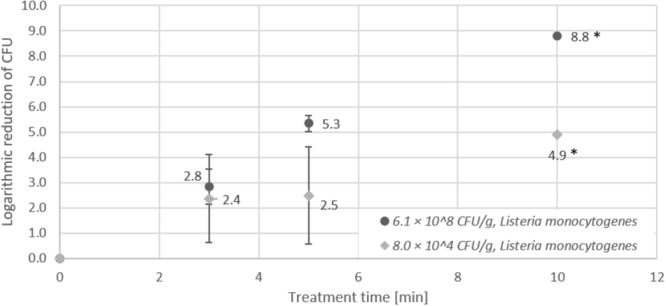
Effect of CAPP treatment of Listeria monocytogenes on lentil seeds. Inoculation was performed either as high initial inoculation (6.1 × 108 CFU/g) or low initial inoculation (8.0 × 104 CFU/g) prior to treatment of seeds for 3, 5, or 10 min in the DCSBD. Logarithmic reductions were represented as log10 CFU/g ± standard deviation. The limit of detection was 10 CFU/g for low initial inoculation and 100 CFU/g for high initial inoculation. Logarithmic reduction below the limit of detection is indicated by an asterisk.